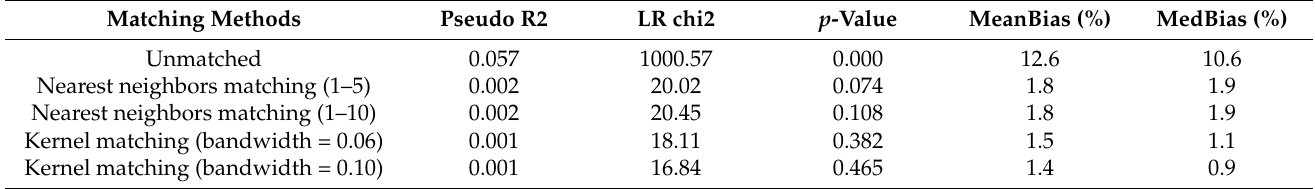
Table 9. Balancing test results for independent variables before and after matching (outcome variable: Overweight). Matching